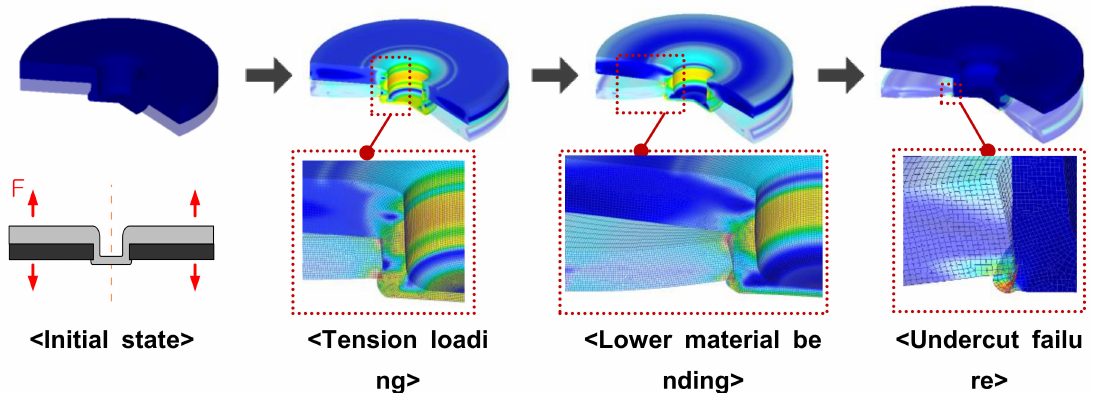
Figure 10. Failure process of hole clinched joints for Case